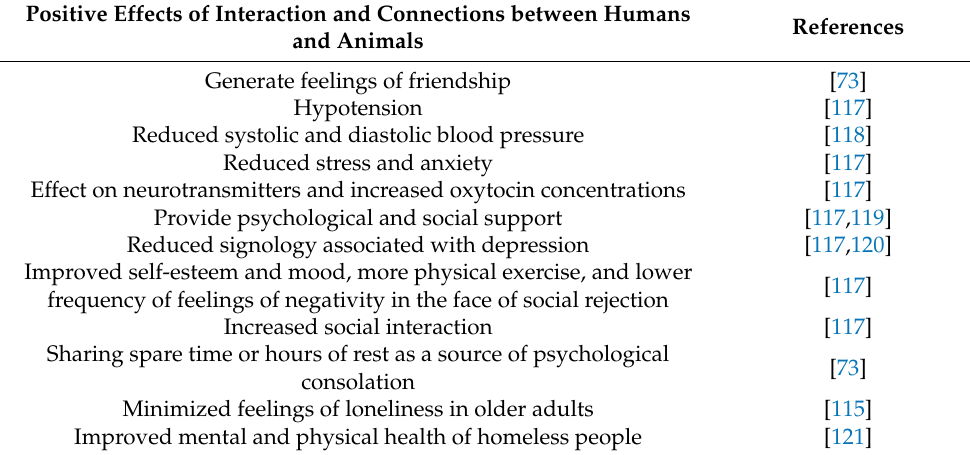
Table 1. Positive effects that humans develop through interaction with companion animals. Positive Effects of Interaction and Connections between